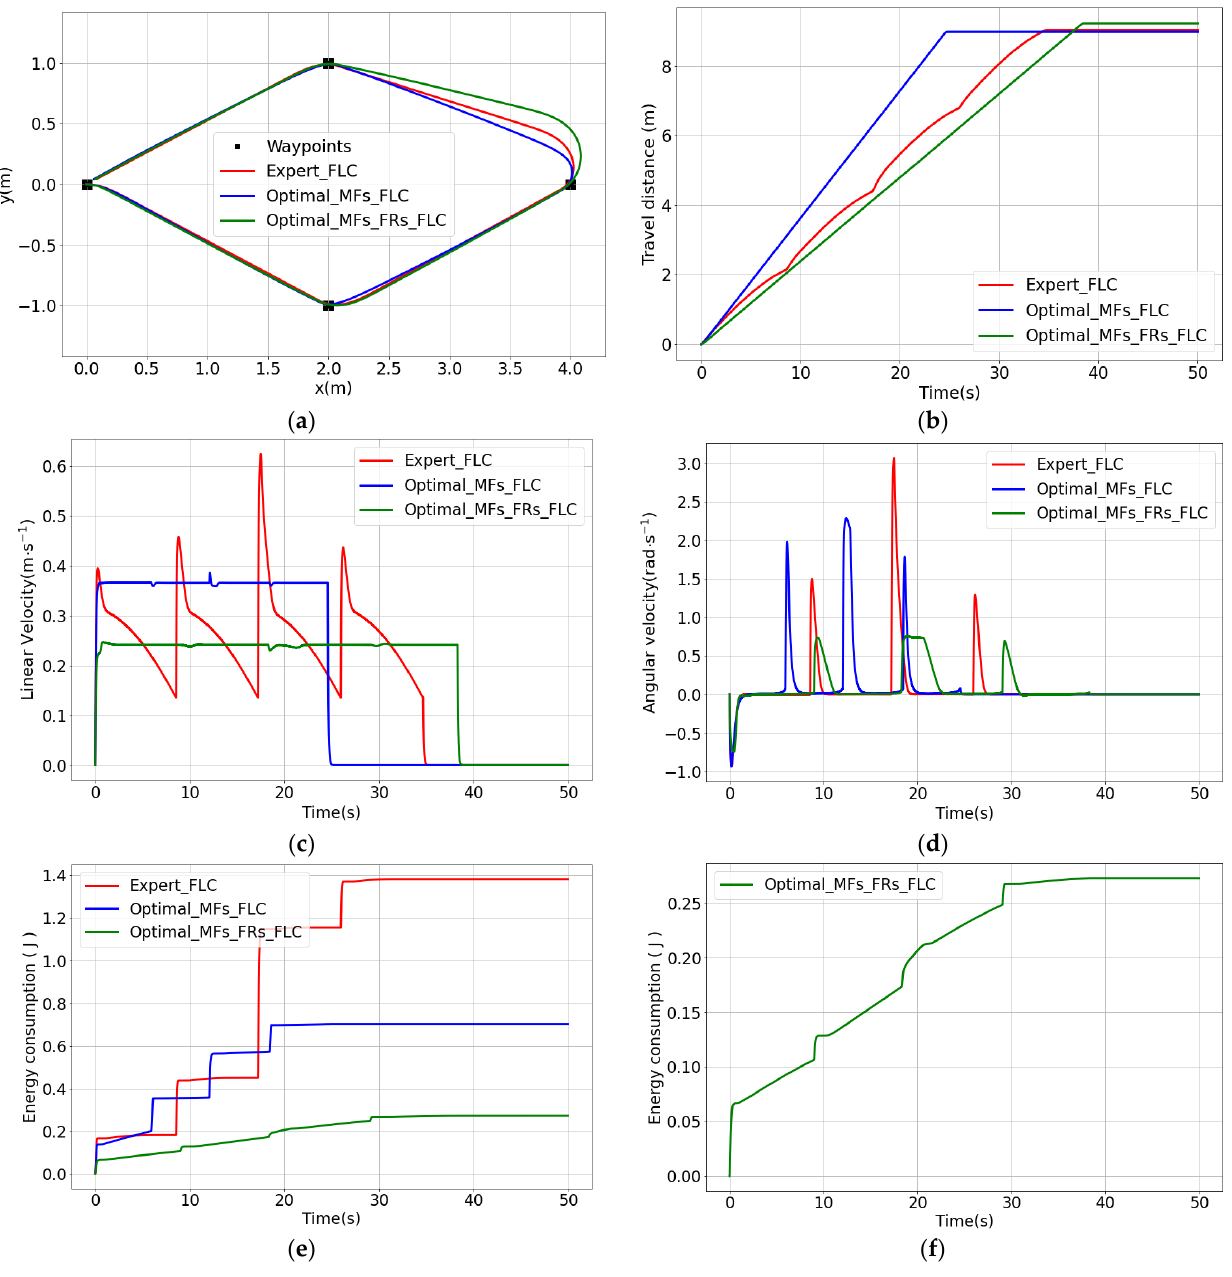
Figure 18. The simulation results in the case of using the diamond-shaped path. ( a ) The trajectory of the robot; ( b ) The robot’s travel distance over time; ( c ) The robot’s linear velocity over time; ( d ) The robot’s angular velocity over time; ( e ) The robot’s kinetic energy loss over time; and ( f ) The zoom of the robot’s kinetic energy loss over time. Table 18. The kinetic energy loss and the travel distance of the robot when the robot tracks the diamond-shaped path by the different